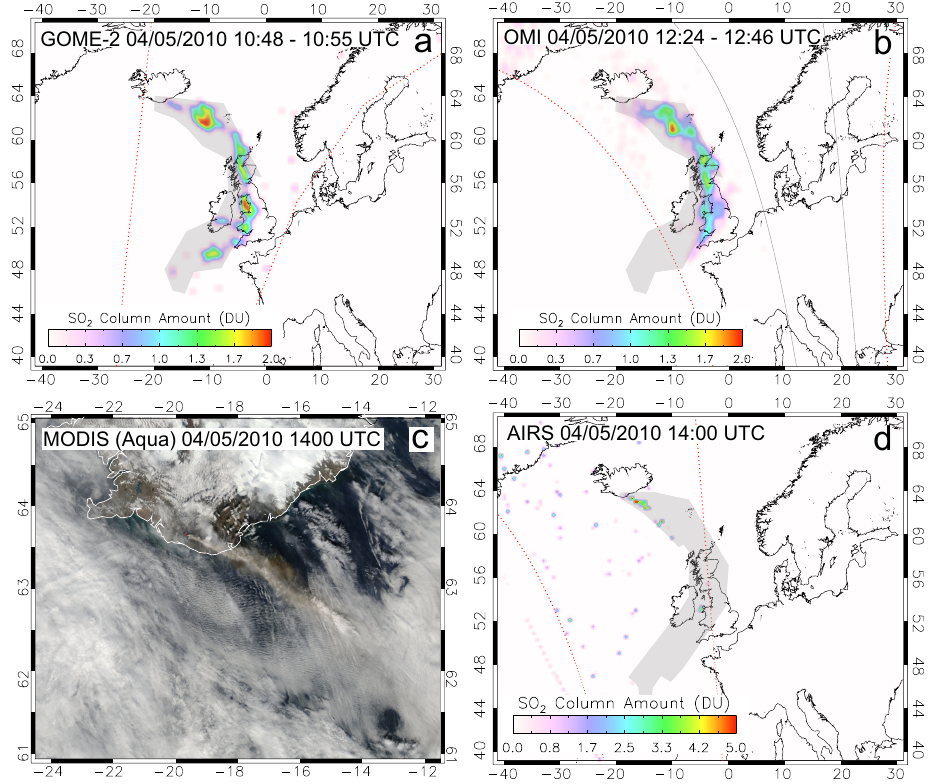
Fig. 3. SO 2 retrievals from GOME-2, OMI and AIRS on 4 May 2010 ( a, b and d ) and the visible image from the MODIS instrument on the Aqua platform showing the ash plume as it leaves the volcano. As before, red dashed lines indicate the swath edge of the polar orbiting instruments and grey lines indicate the limit of the OMI row anomaly, between which no useable data are recorded. The grey shaded region indicates the area predicted to contain ash as forecast by the London VAAC at the time of the eruption.